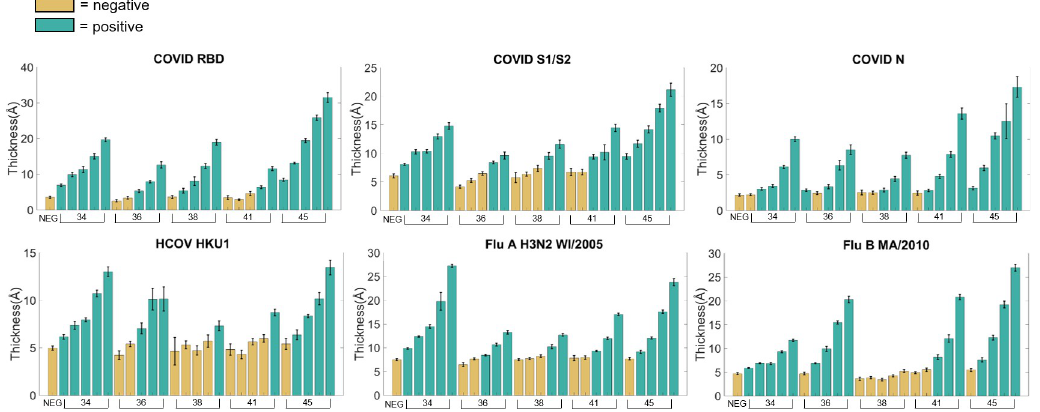
Fig 3. Serial dilutions of selected convalescent serum samples. Dilutions were two-fold (1:20, 1:40, 1:80, 1:160, 1:320) on serum samples HD2134, HD2136, HD2138, HD2141, and HD2145. Positive samples are significantly different from the negative control sample by t-test, p <